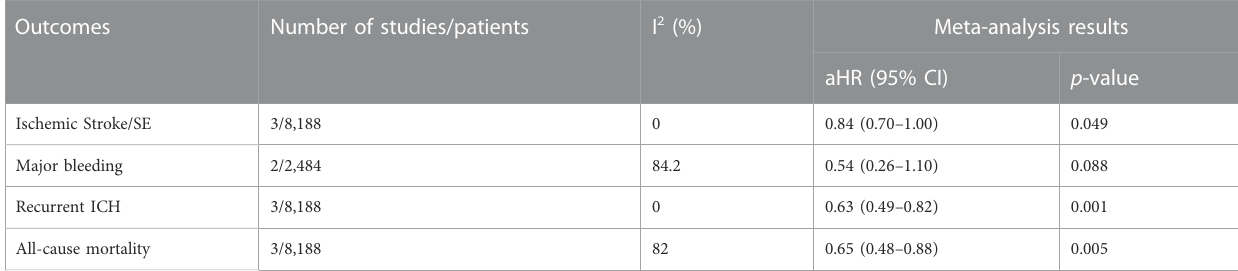
TABLE 3 Results of Comparison effectiveness and safety of DOACs versus